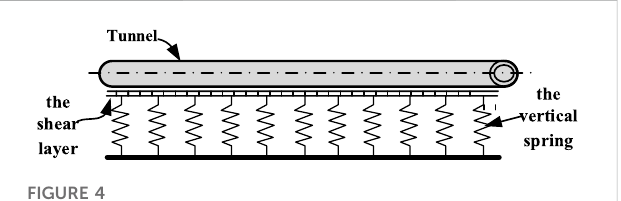
FIGURE 4 Pasternak-Timoshenko foundation beam model.